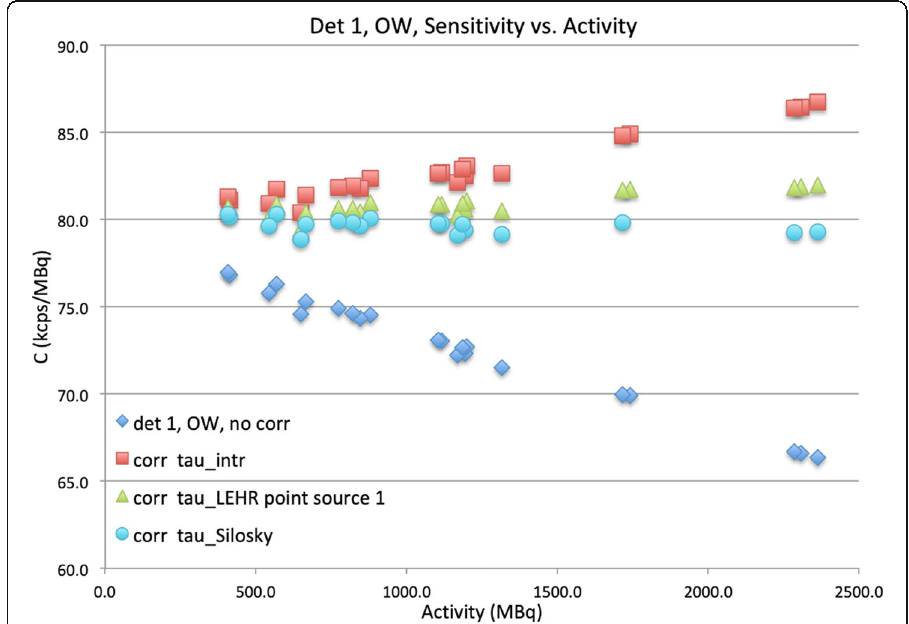
Fig. 7 Dead time corrections for the OW measurement of the phantom. Sensitivity ( C OW ) in kcps/MBq vs. A (MBq) for the second extrinsic phantom measurement, detector 1, open window, with values of τ OW from different measurements used for correction: blue diamonds, uncorrected; red squares, τ OW from the intrinsic point source measurements (from Table 2); green triangles, τ OW from the first extrinsic point source measurement (Table 4); and cyan circles, τ value of Silosky [3] (based on